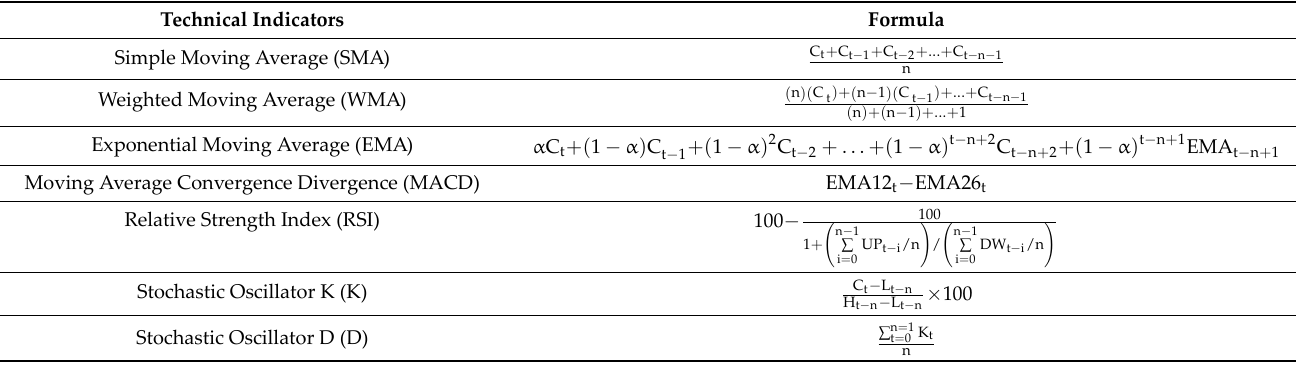
Table 4. Technical indicators and